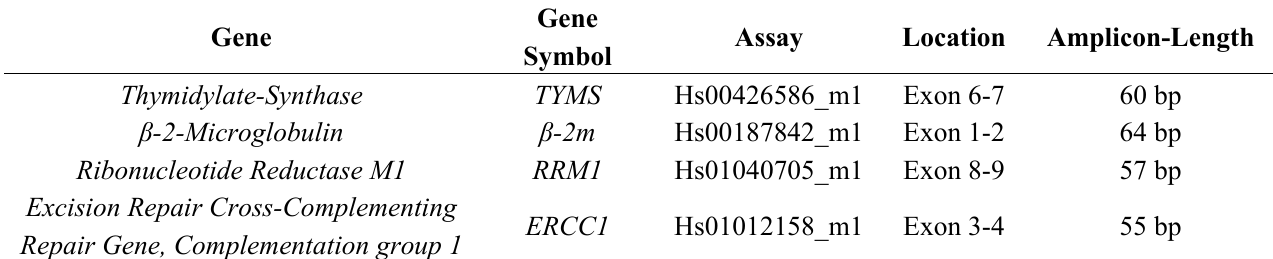
Table 1. Highly purified salt-free primers for gene targeting